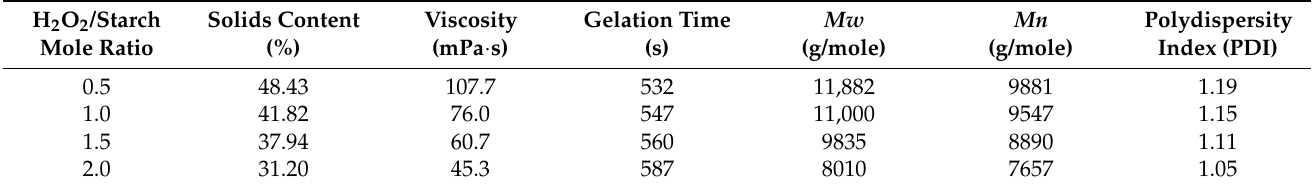
Table 2. Properties of oxidized starch adhesive at different H 2 O 2 /starch mole ratios [56]. H 2 O 2